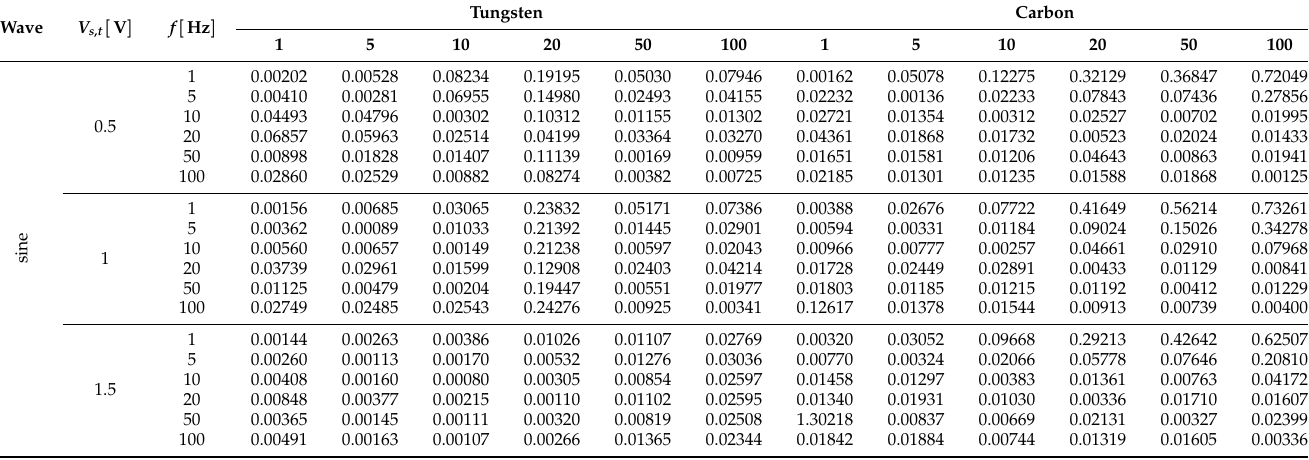
Table 4. Cost function values if the optimal model parameters obtained for certain frequency are applied for the data of different frequency. The VTEAM model is